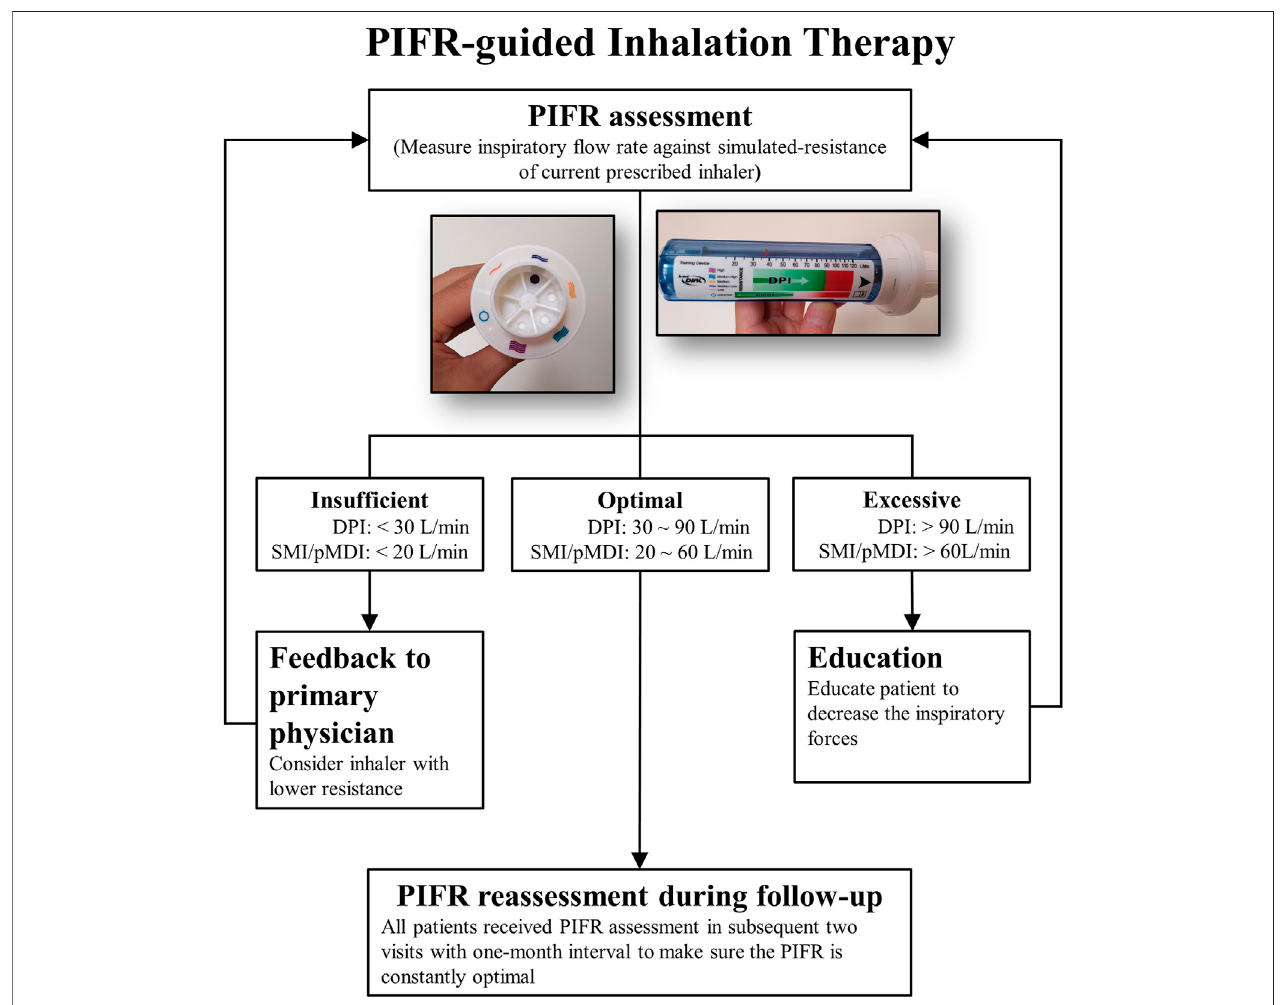
FIGURE 1 | Peak Inspiratory Flow Rate guided inhalation therapy; DPI: dry powder inhaler; SMI: soft mist inhaler; pMDI: pressurized metered dose inhaler; PIFR: peak inspiratory fl ow rate.